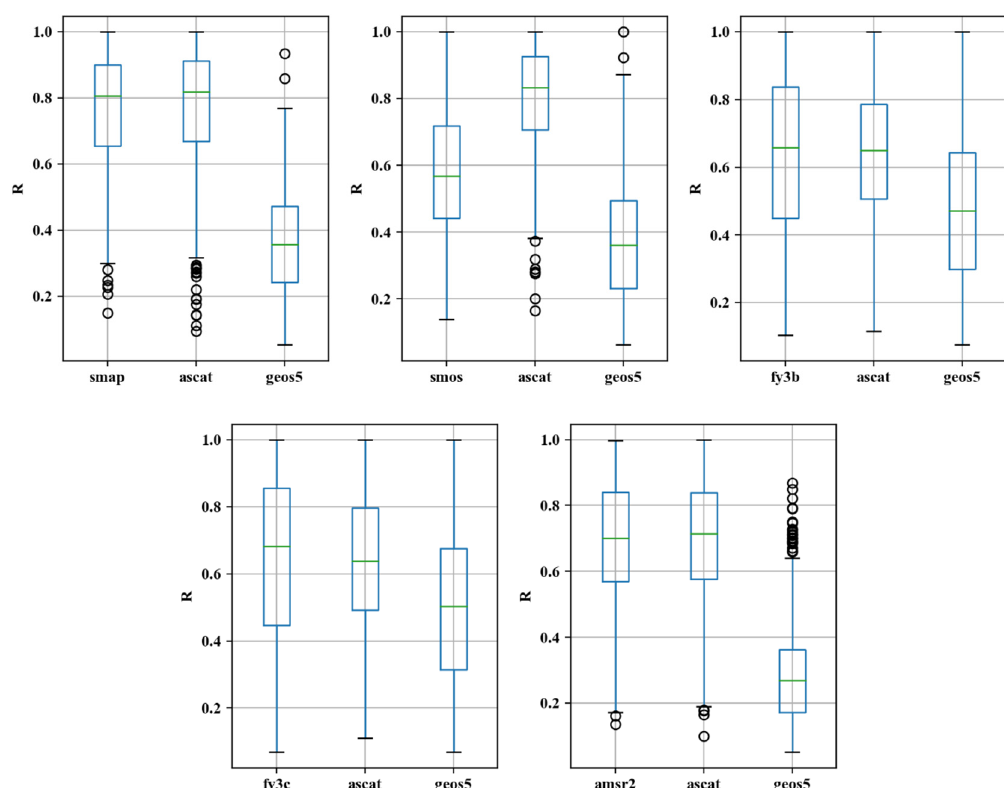
Figure 9. Tail box figure of R in the study area.